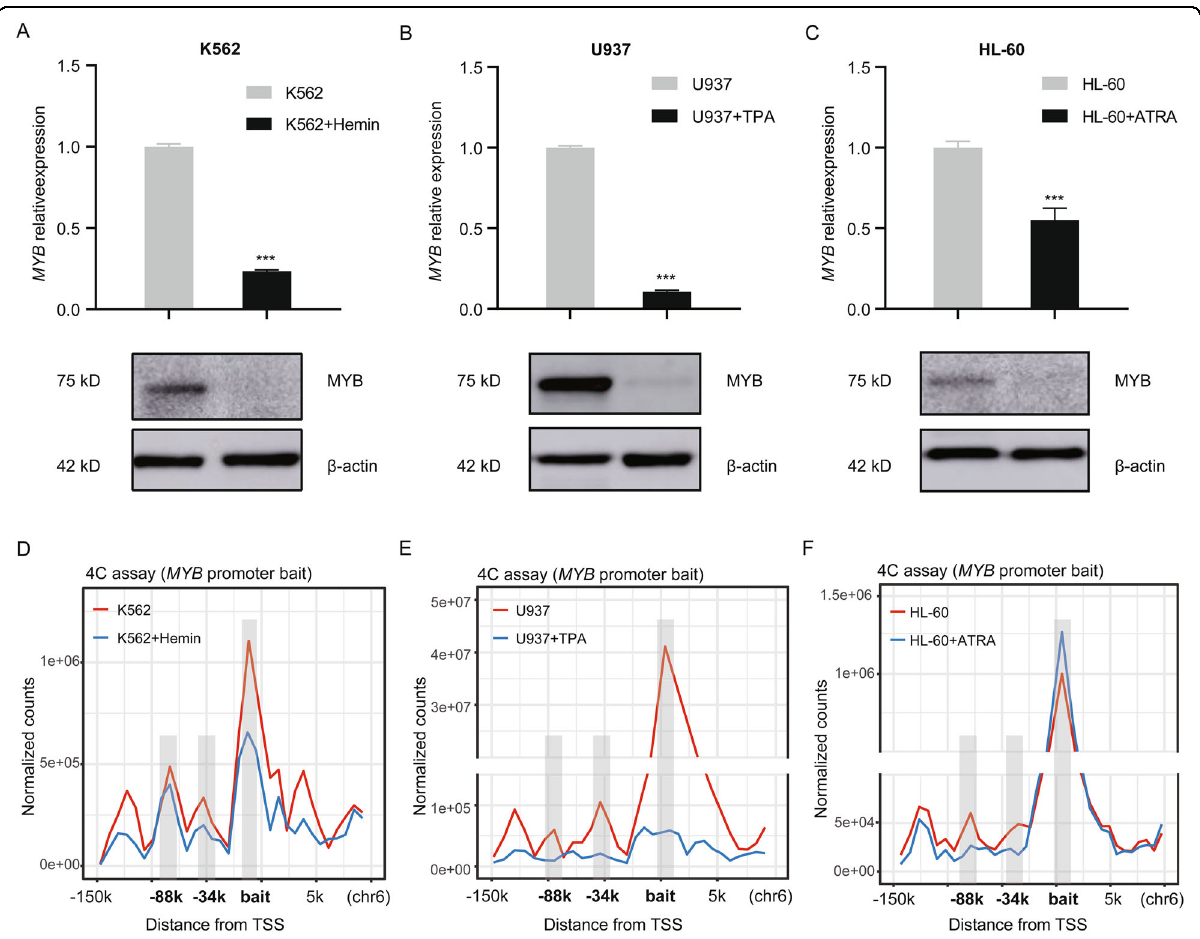
Fig. 3 Dynamic long-range interaction of the MYB locus during differentiation of human leukemia cells. K562, U937, and HL-60 cells were treated with hemin, TPA and ATRA for erythroid, monocytic, and granulocytic differentiation, respectively. Then A – C MYB mRNA (upper) and protein (lower) levels were determined in K562 ( A ), U937 ( B ), and HL-60 ( C ) cells, using RT-qPCR and Western blot respectively. Gapdh was used as an internal control, β -actin was used as a loading control. Data are represented as mean ± SD of three independent experiments, and P values are calculated using Student ’ s t -test (* P < 0.05; ** P < 0.01; *** P < 0.001) in A – C . D – F 4C assay was performed with the MYB promoter as viewpoint in indicated cells. Diagrams show the change of near-bait interactions on chromosome 6 in K562 ( D ), U937 ( E ), and HL-60 ( F ) cells during differentiation, the distribution plots of normalized read counts were generated by the 4C-ker to visualize proximity of the peaks to the bait. Interacting upstream regions of the MYB locus were highlighted. Distance of marked regions from transcription start site (TSS) is